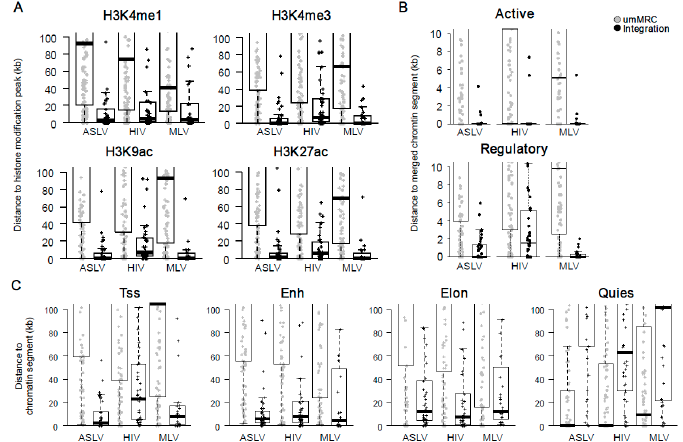
Figure 5. Epigenetic features at the integration sites of stably expressed ASLV, HIV and MLV proviruses.